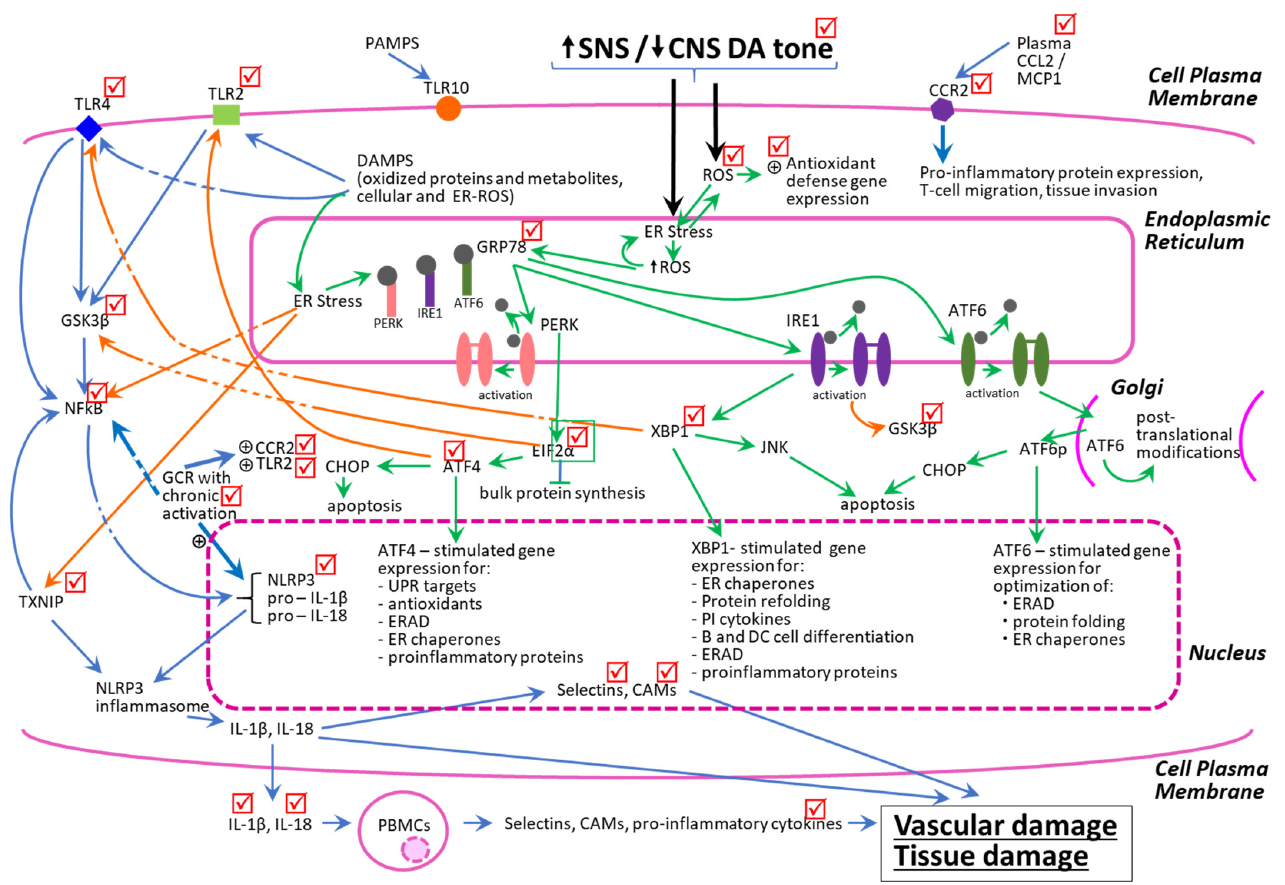
Figure 7. Schematic representation of the interacting dynamics of PBMC pro-oxidative and pro-inflammatory-state biochemical pathways. The check marks represent molecular sites of bromocriptine-QR action to reduce gene expression or plasma levels of pro-oxidative/pro-inflammatory factors. The green arrows represent ER stress-related actions, the blue arrows represent TLR-initiated pro-inflammatory pathways, and the orange arrows represent crosstalk activities between the ER stress and TLR-activated pathways leading to potentiation of vascular disease. All arrows indicate stimulation of gene expression and/or protein synthesis/activation of the target.